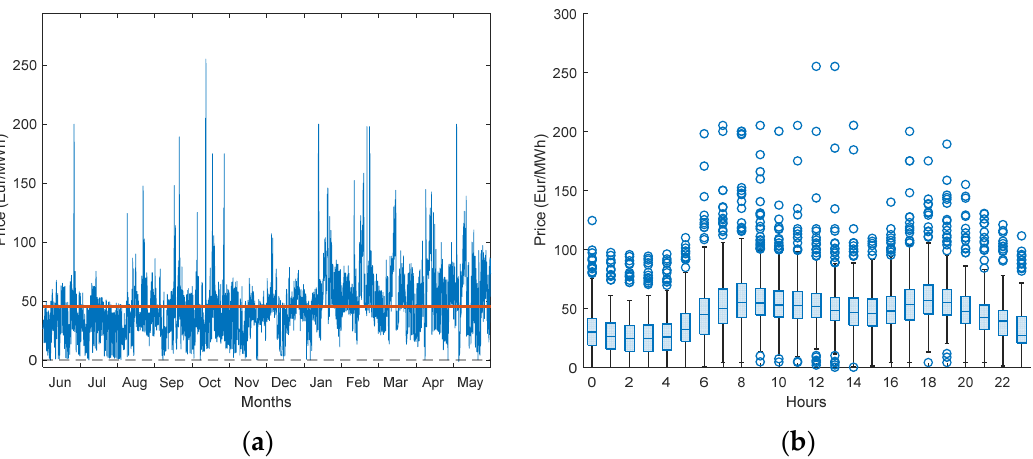
Figure 9. 3D power difference profile of the DSPI digital twin and the reference inverter.